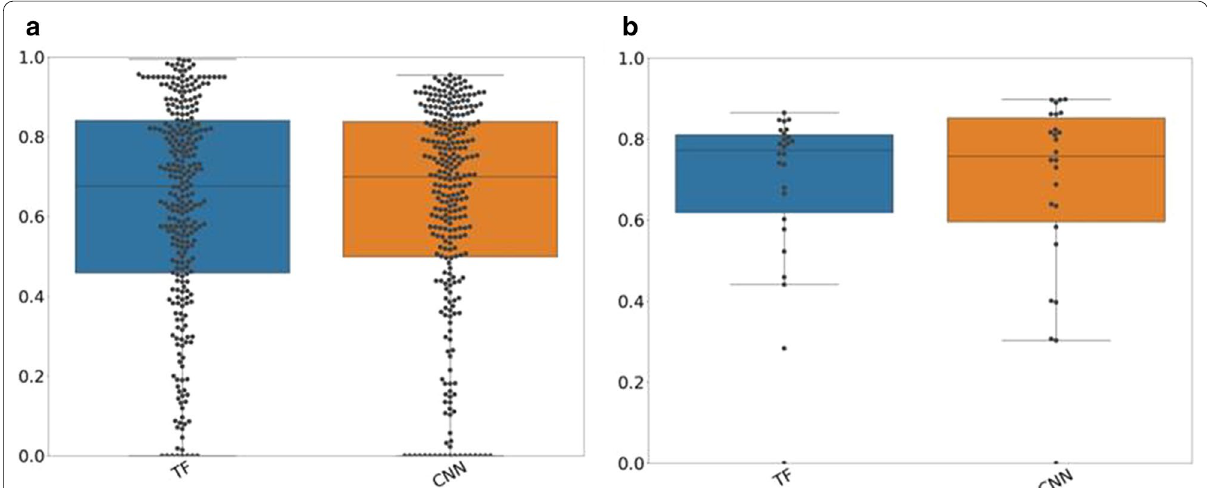
Fig. 4 Jaccard coefficient (JC) values for both datasets: JC values for the cross-validated dataset (left figure) and the test–retest dataset (right figure) for the AI-based segmentation algorithm included in the study